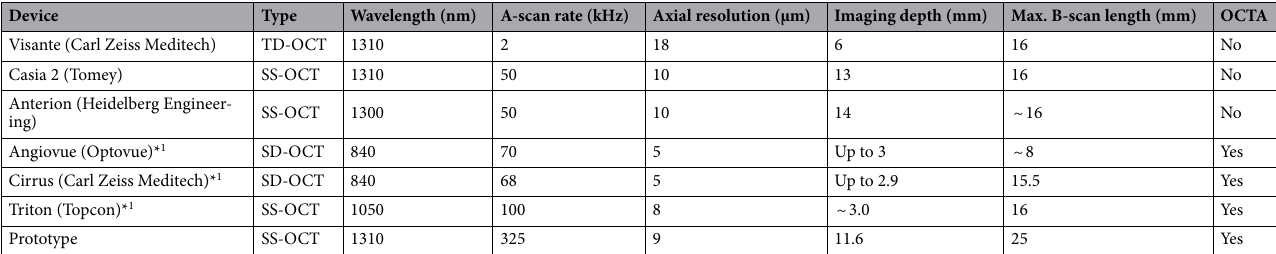
Table 1. Comparison of selected commercial OCT instruments and the SS-OCT prototype instrument. Axial resolution and imaging depth reported correspond to values in tissue.TD-OCT = time domain OCT. * 1 Retinal OCT instruments. Imaging the anterior eye is possible through the use of accessory